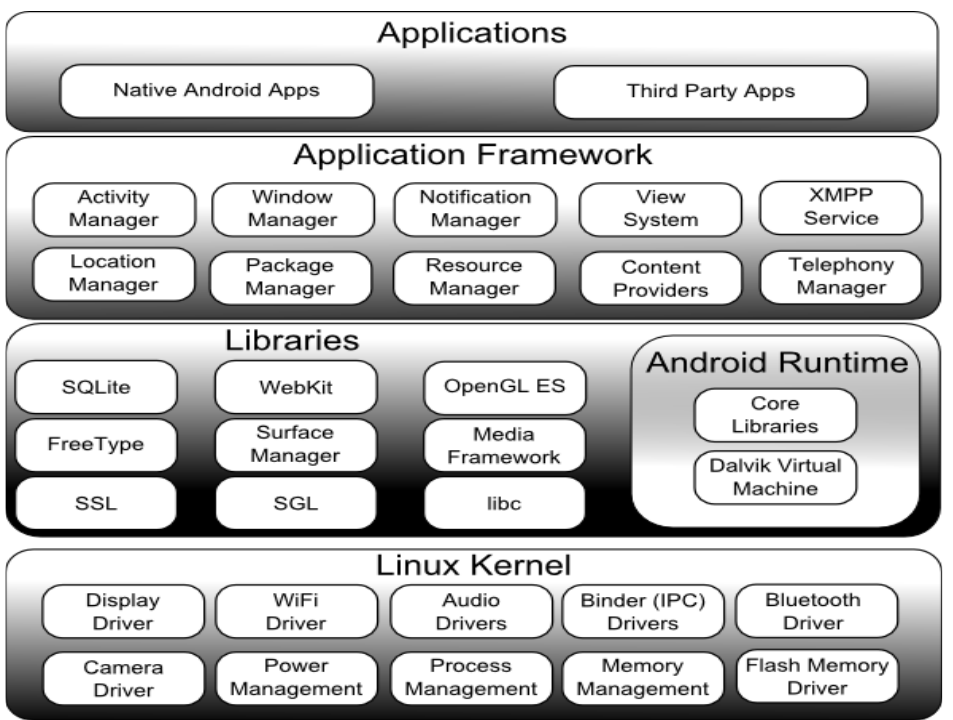
Figure 1. Linux kernel structure (Smyth,